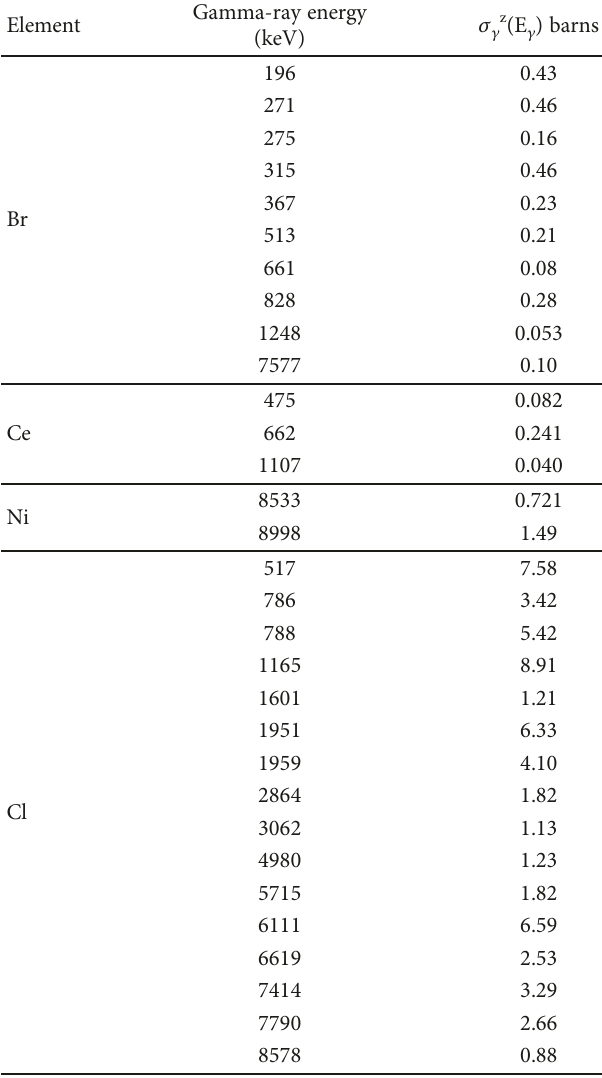
Table 1: Energies and partial elemental cross section σ barns of prominent capture gamma rays of bromine, cerium, and chlorine